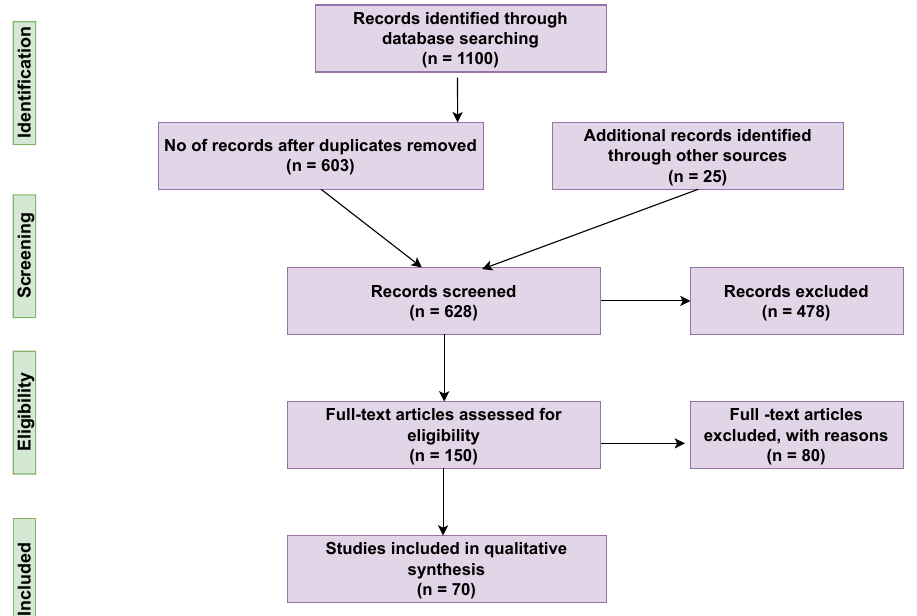
Figure 1. PRISMA-based flow diagram used for articles’ systematic